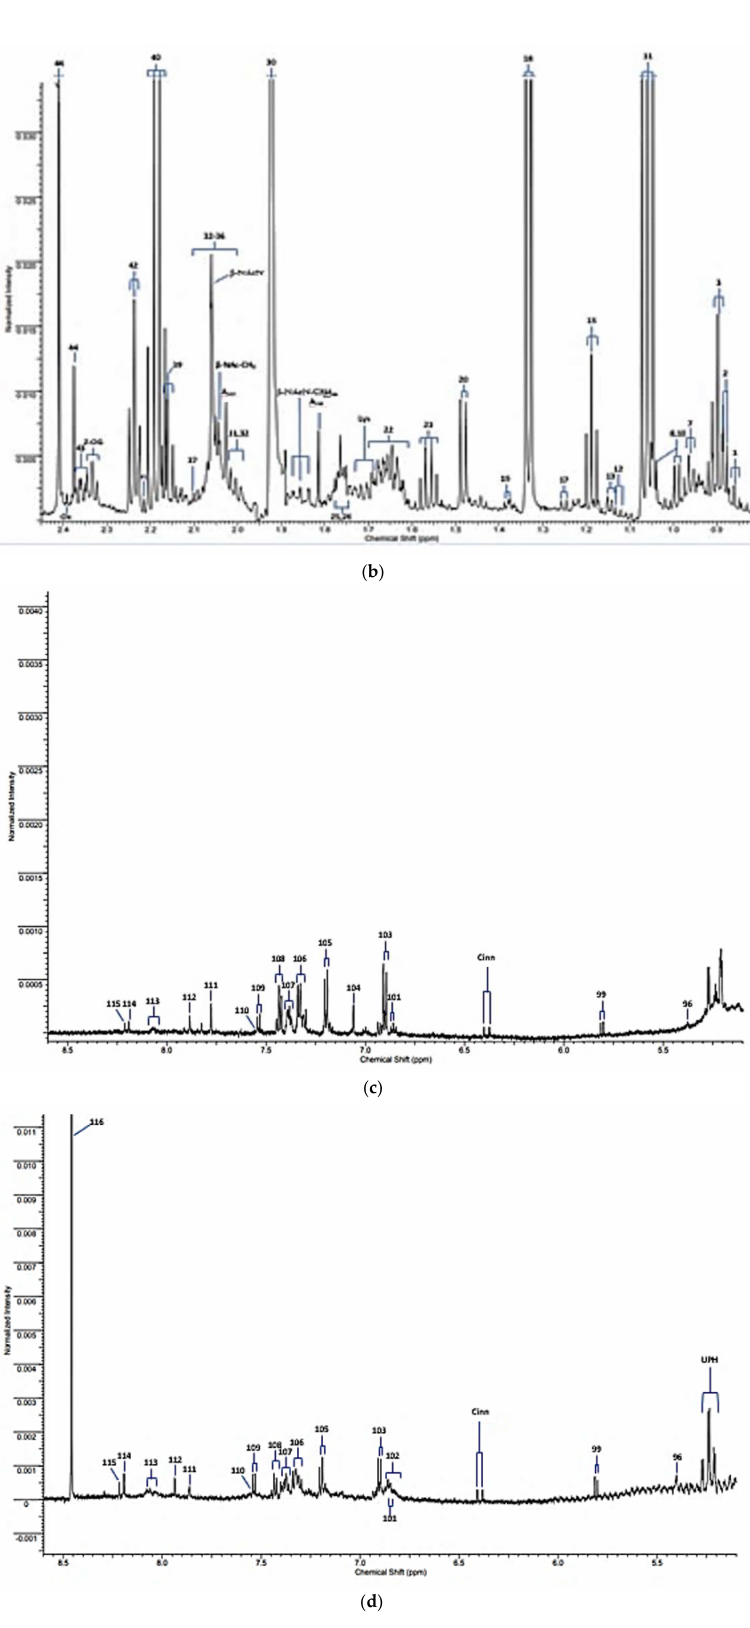
Salivary ISB intensities were normalised to that of an added TSP internal standard. 1 H NMR data matrices (480 spectra × 209 ISB buckets, or 480 spectra × 31 assigned named metabolites) were produced via the employment of macro processes for line-broadening, zero-filling, Fourier-transformation, and phase and baseline corrections. This was followed by the application of a separate macro system for the intelligent bucketing of spectral resonances. All unwanted interfering resonances (exclusively that of the highly intense H2O/HOD at δ = 4.8 ppm), together with all spectral ‘noise’ regions, were removed from the spectral profiles acquired prior to performing the bucketing process. These computations were executed using the ACD/Labs 1D NMR Manager software package (Advanced Chemistry Development, Inc. (ACD/Labs), Toronto, ON, Canada). MV data analysis was then performed using MetaboAnalayst 5.0 software modules. This software approach was largely employed to explore the applications of PLS-DA and sparse PLS-DA (sPLS-DA) analyses of the large dataset acquired, and to determine the differential effects of row-wise probabilistic quotient and constant sum normalisation approaches (PQN and CSN, respectively) on the results acquired. Hence, where imputed, datasets were row-wise normalised using either of these approaches, the latter involving expression of all ISB intensities to that of an average 1 H NMR spectral profile computed from the H NMR profiles of all healthy control group WMSS samples acquired. Both these normalisation methods serve as a means of overcoming problems with dehydration- mediated increases in the salivary concentrations of metabolites in the active sore throat group of participants. These further row-wise normalisation strategies were applied subsequent to the performance of the TSP normalisation process. All datasets were then generalised logarithmically (glog-) transformed and Pareto-scaled prior to data analysis.